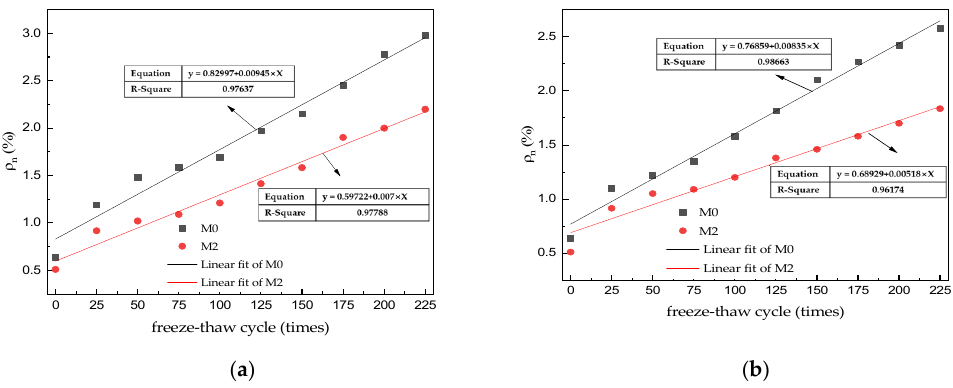
Figure 4. Fitting curve of water absorption of MKPC specimen. ( a ) Freeze–thaw cycling in H 2 O ; ( b ) Freeze–thaw cycling in 5% Na 2 SO 4 .